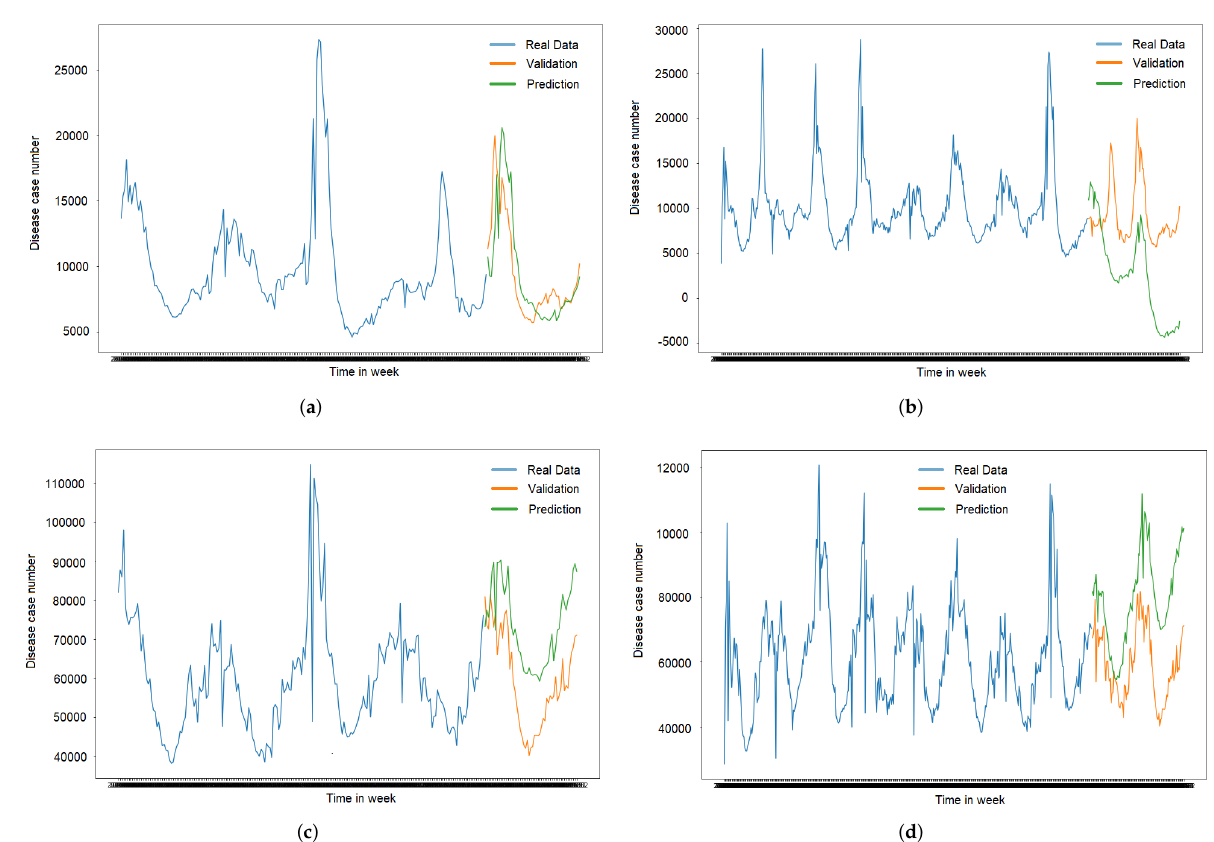
Figure 5. ILI and Respiratory ARIMA models. ( a ) ILI from 5 years dataset training; ( b ) ILI from 10 years dataset training; ( c ) Respiratory from 5 years dataset training; ( d ) Respiratory from 10 years dataset